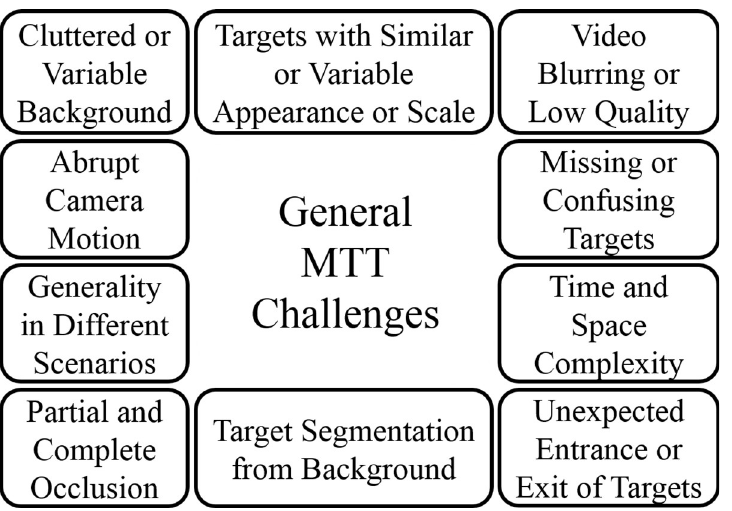
Fig 1. MTT general challenges. MTT, multiple-target